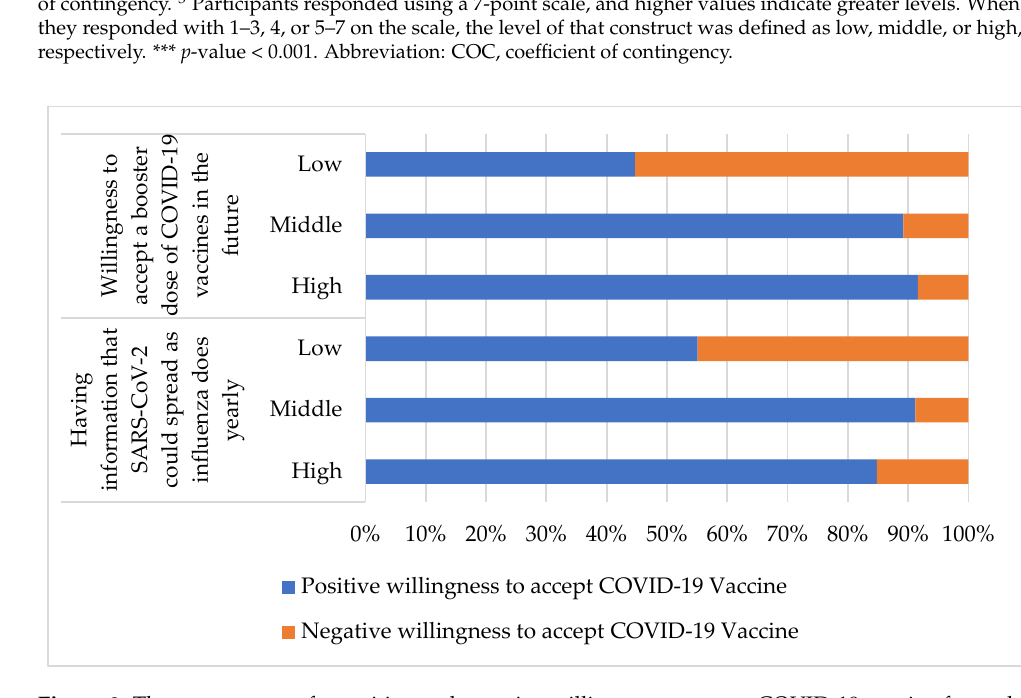
Figure 3. The percentages of a positive and negative willingness to accept COVID-19 vaccine for each item in Table